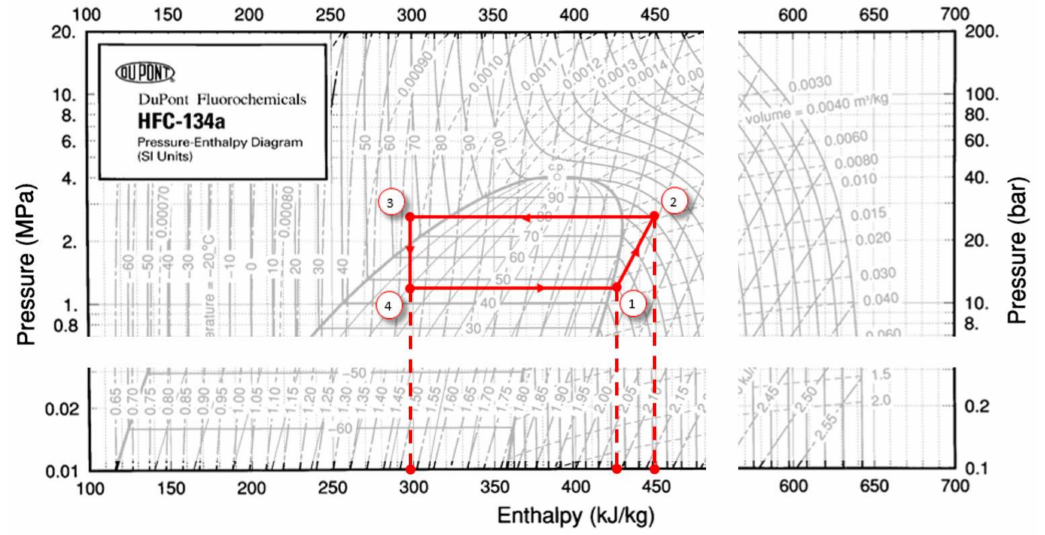
Figure 17. 1,1,1,2-Tetrafluoroetan (HFC-134a) cycle of proposed high temperature heat pump presented on p-H